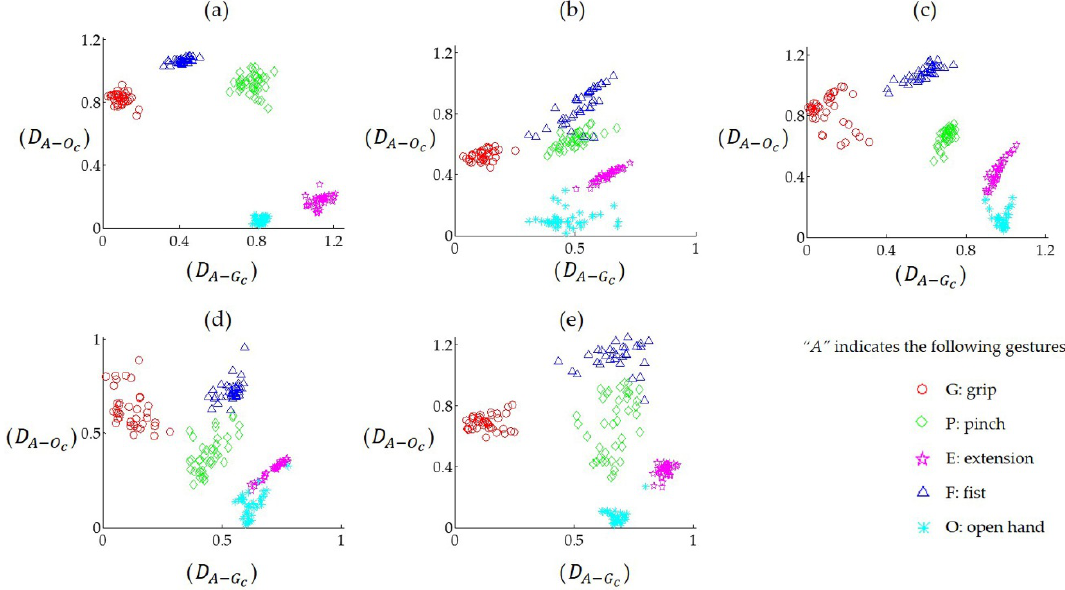
Figure 7. The distribution of the gesture features illustrated by the distances from the data points to the specific centroids (defined by Equation (7)) in the feature space. The x-axis ( D A − G ) was the distance from the data samples of the A class gesture to the centroid of the grip gesture (G) and the y-axis ( D A − O ) was the corresponding distance between data samples of A gesture to the centroid of the open hand gesture (O). Sub-plots of ( a ), ( b ), ( c ), ( d ), and ( e ) present one participant each. Different gestures can be visually distinguished from the scatter plots.